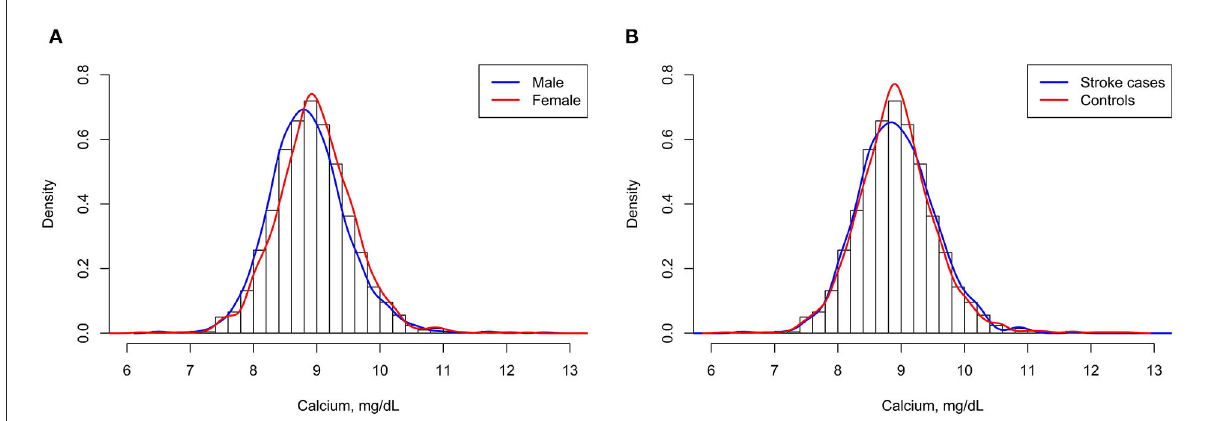
FIGURE1 Serum albumin-corrected calcium distributions of men and women (A) and stroke cases and control subjects (B)